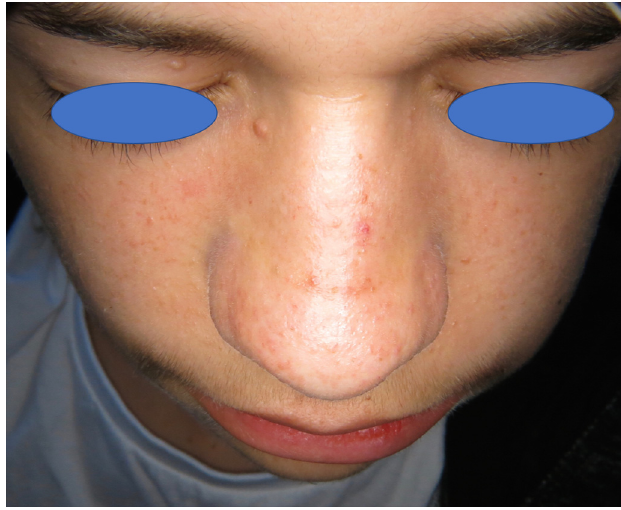
Fig. 3. Facial angio